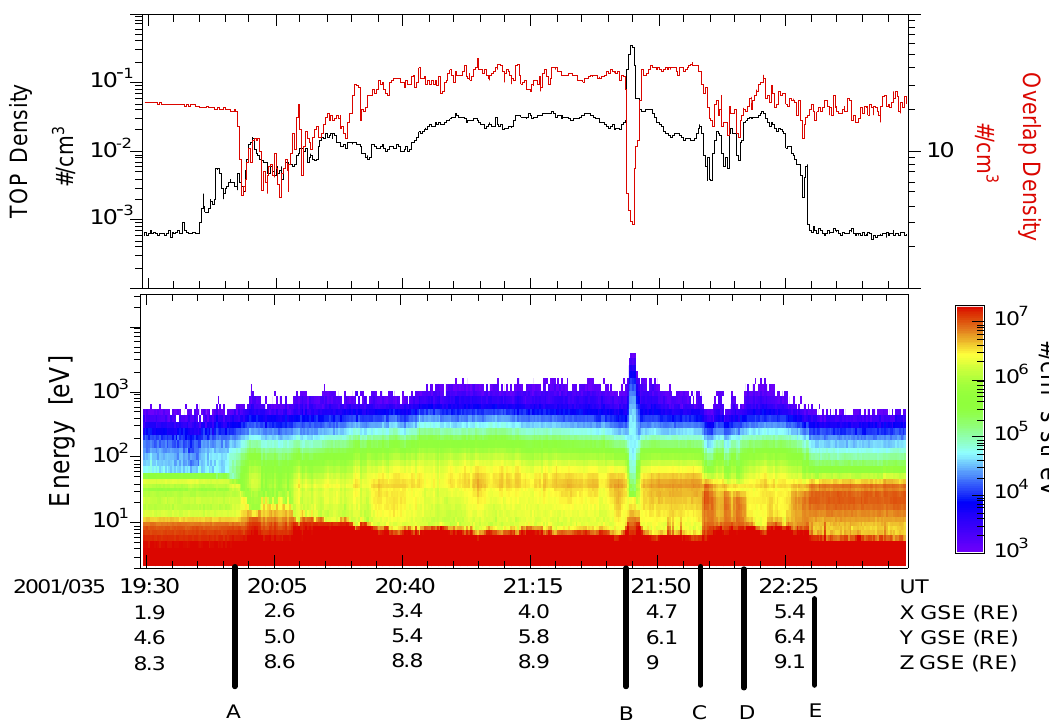
Fig. 9. Energy spectra and density moments from 4 February 2001, 19:30–23:00 UT in same format as Fig. 3.